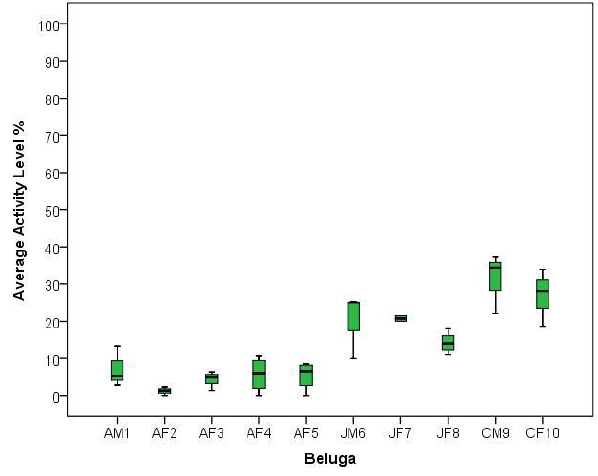
Figure 8. Boxplots of average overall activities percentage per individual beluga. Note the scale is a